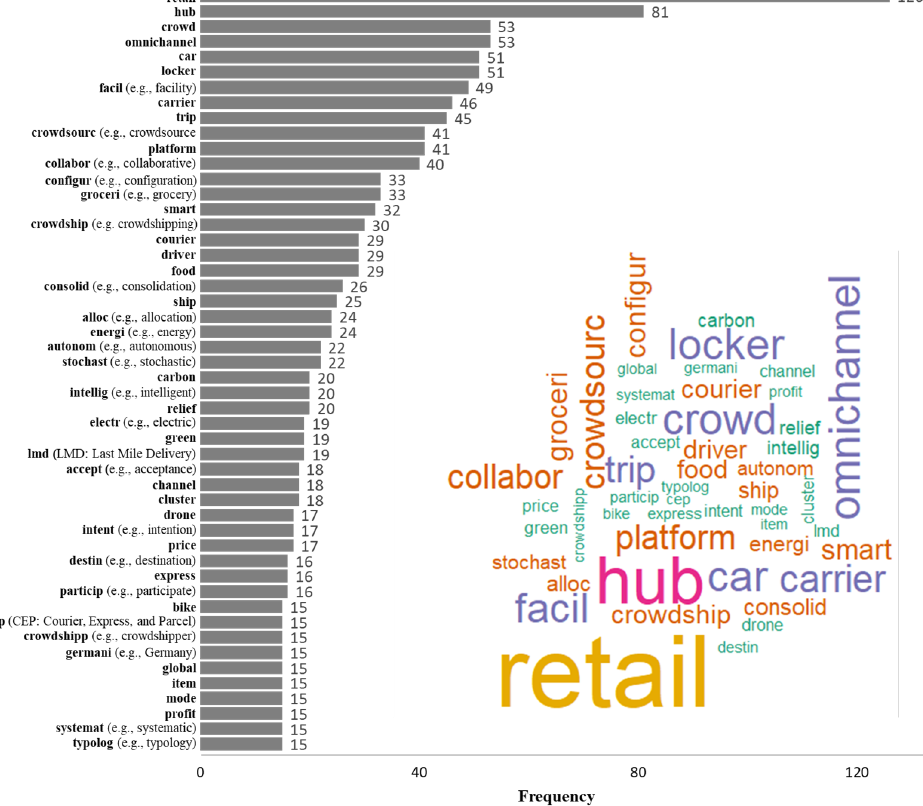
Figure 4. The 50 most frequent terms identified from the target research